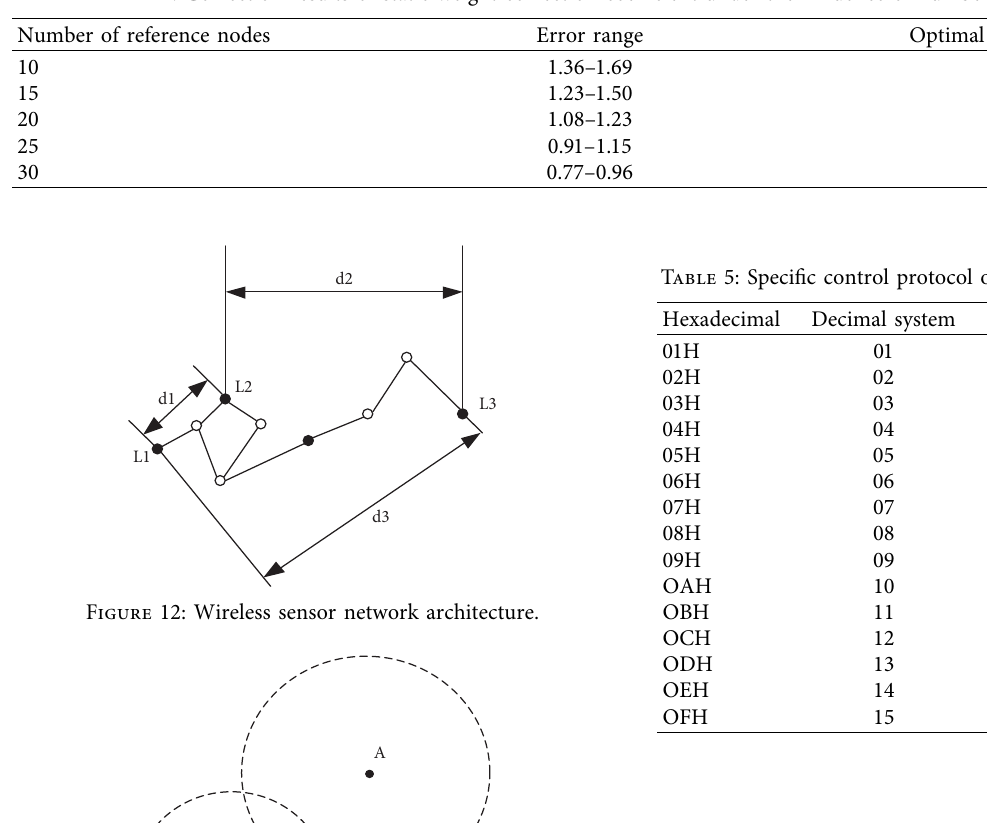
Table 4: Correction results of static weight correction coefficient under the influence of number of reference nodes.